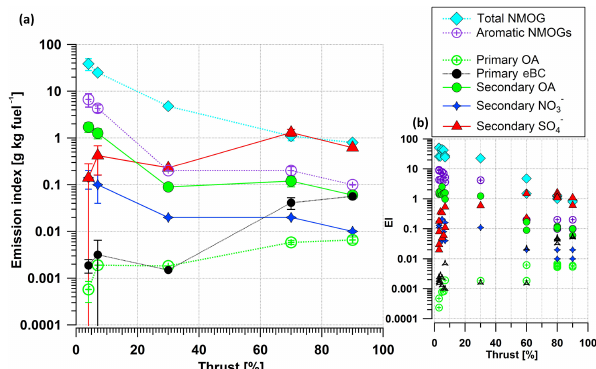
Figure 3. Average emission indices (a) and EIs from individual test points (b) for primary nonmethane organic gases (NMOGs), aro- matic gases, primary organic aerosol (POA), equivalent black car- bon (eBC), secondary organic aerosol (SOA), nitrate (NO 3 ), and sulfate (SO 4 ). Error bars ( ± ) are the standard deviations of the means with a confidence interval of 95%. The OH exposure was in the range of 91–113 × 10 6 moleculescm − 3 h for the secondary aerosol